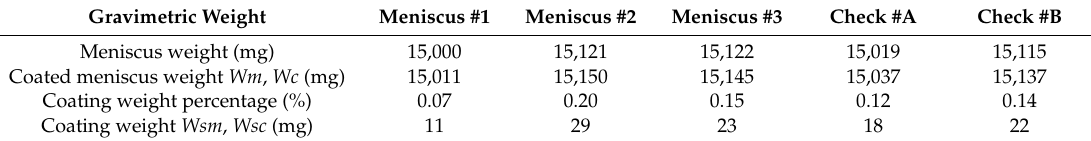
Table 1. Gravimetric results.